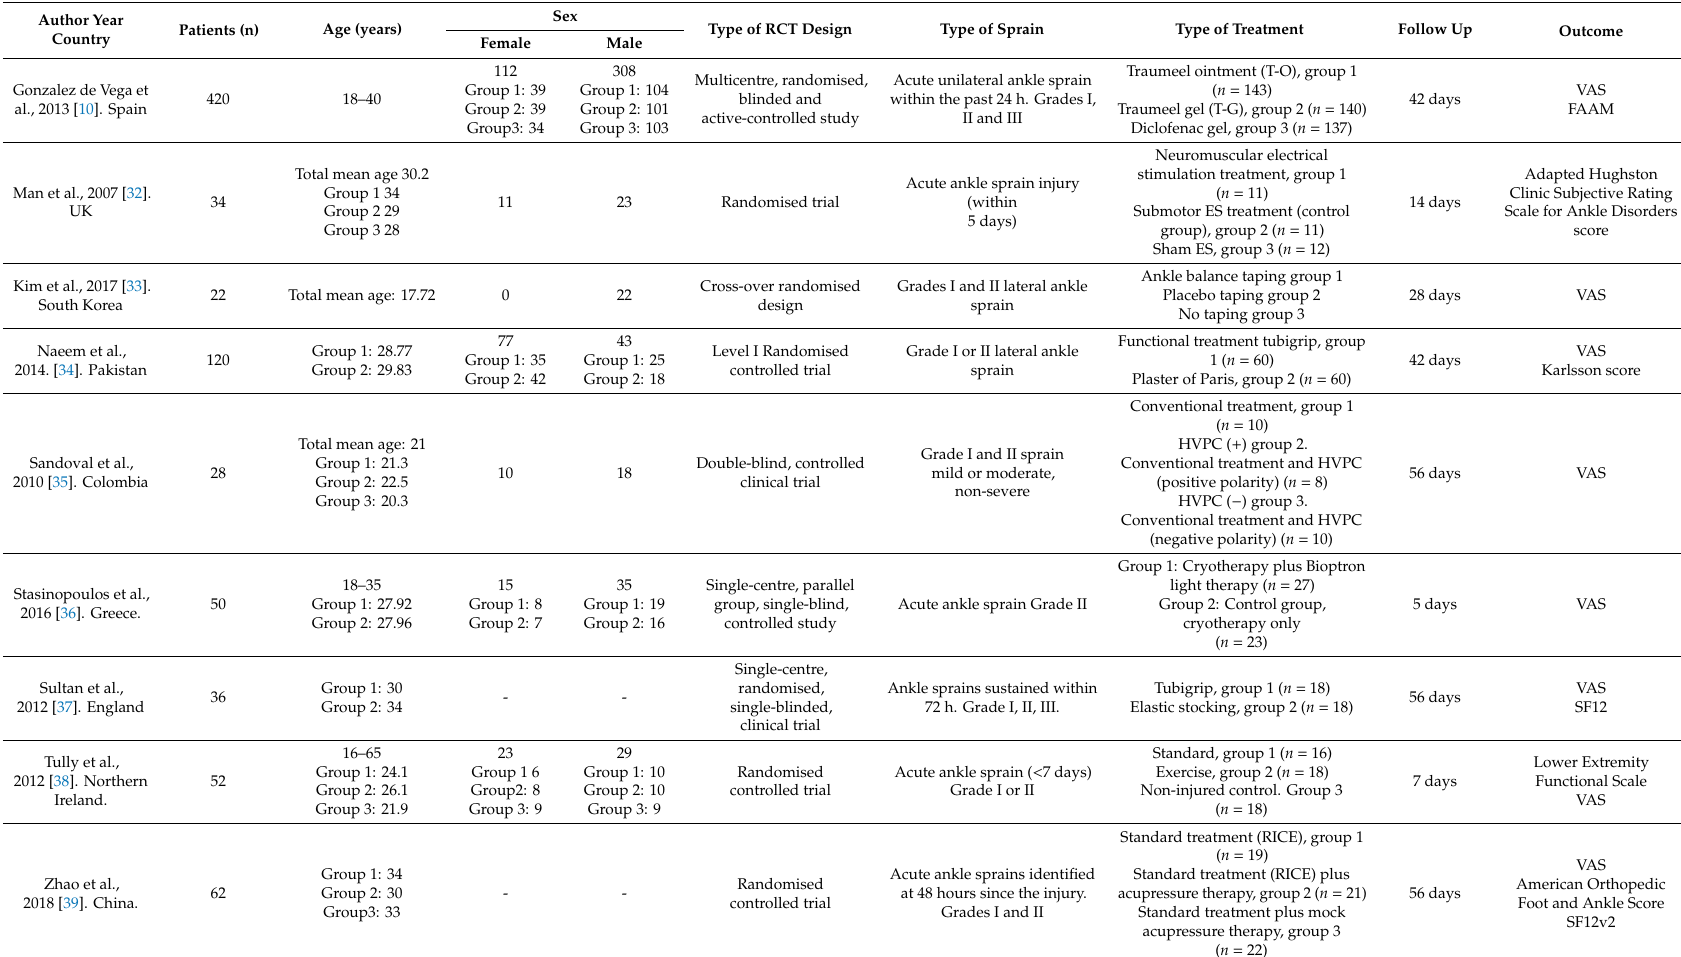
Acute ankle sprain Grade II Ankle sprains sustained within 72 h. Grade I, II, III. Acute ankle sprains identified at 48 hours since the injury. Grades I and II